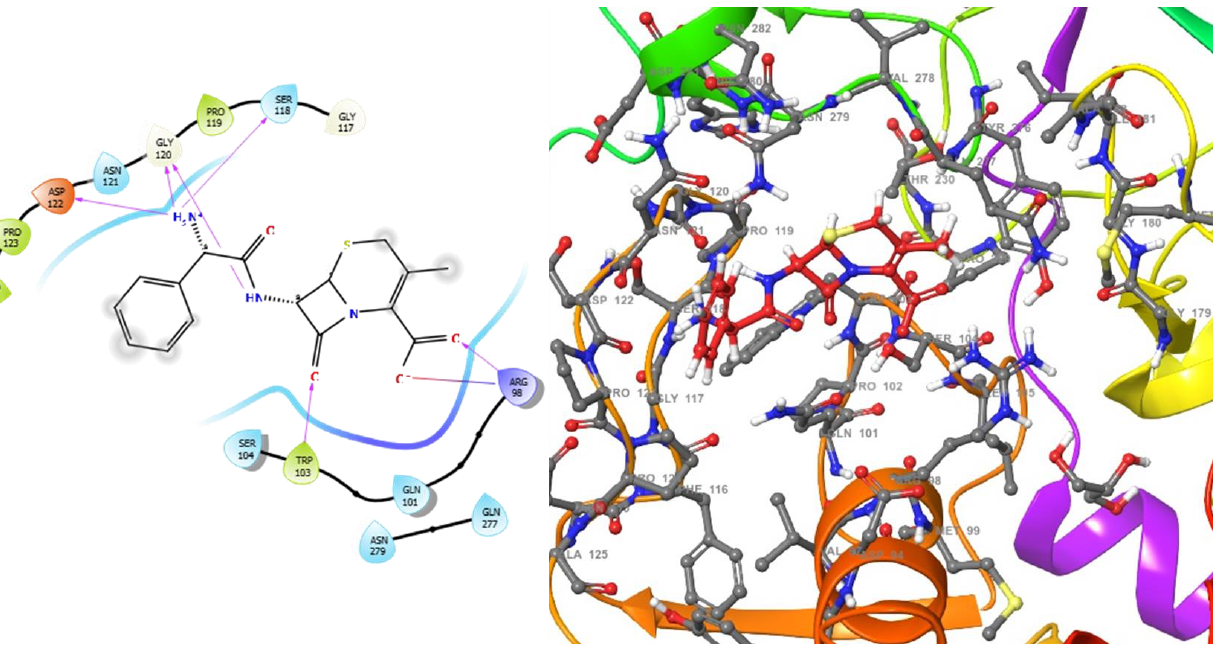
Figure 2. 2D ( left ) and 3D ( right ) views of the molecular interactions at the surface of the active site of the DNA gyrase subunit A N-terminal domain binding with cephalexin (the green stick model). The negative, positive, and neutral charges of the binding site residues are represented with red, blue, and white colors, respectively.